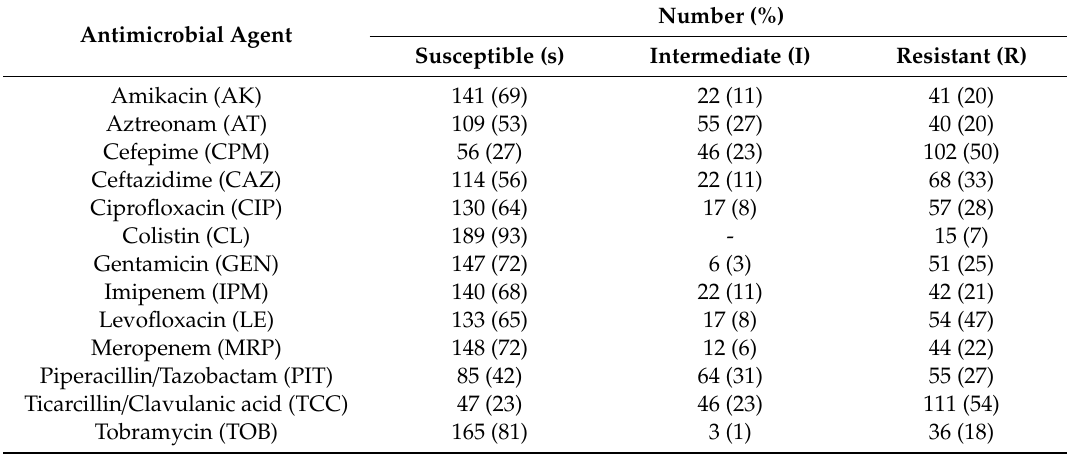
Table 1. Antimicrobial susceptibility of the tested isolates against respective antibiotics. Antimicrobial Agent